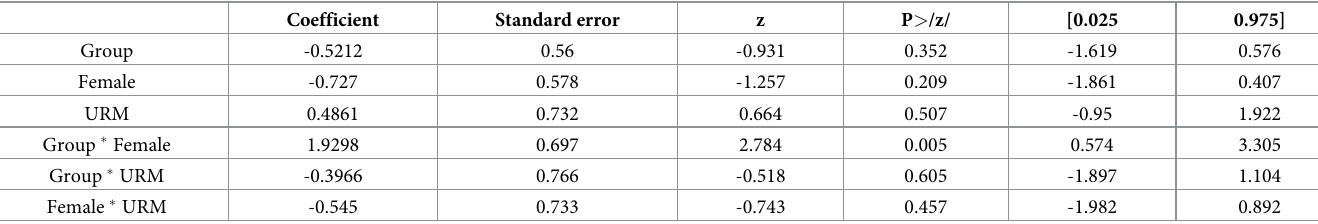
Table 4. Logistic regression